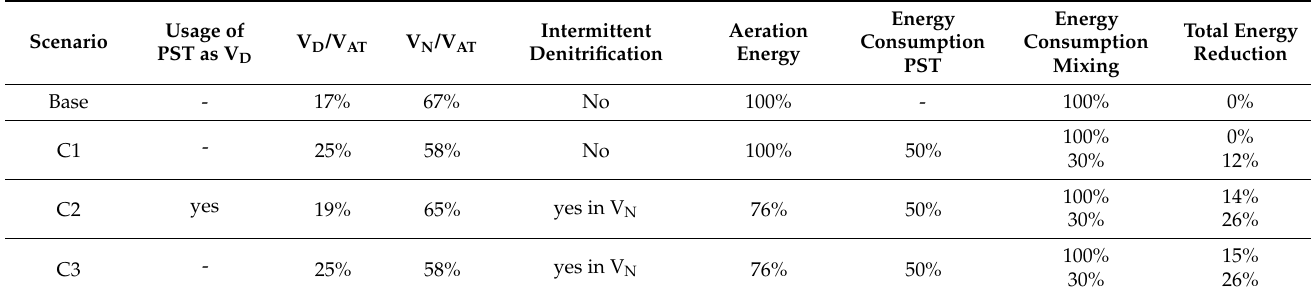
Table 7. Total energy reduction by the different tested combinations of